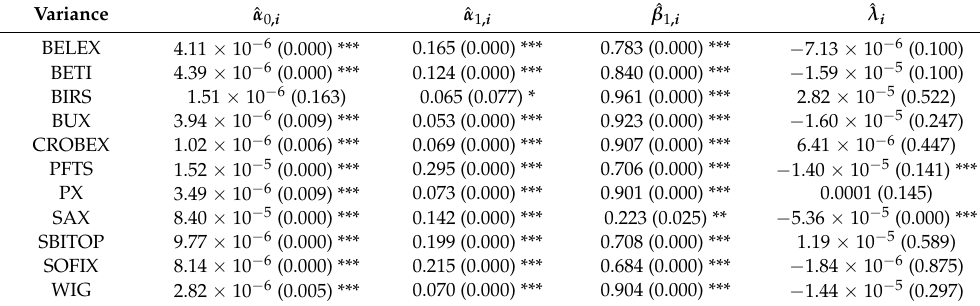
Table A3. GARCH estimation results, binary variable for 10 days after the event.